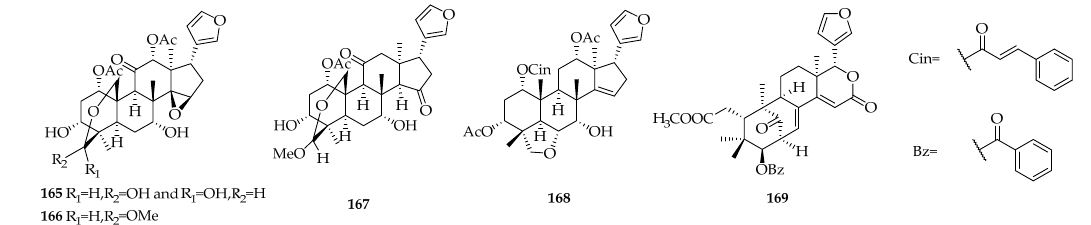
Figure 7. Chemical structures of limonoids 165 – 169 from other plants.